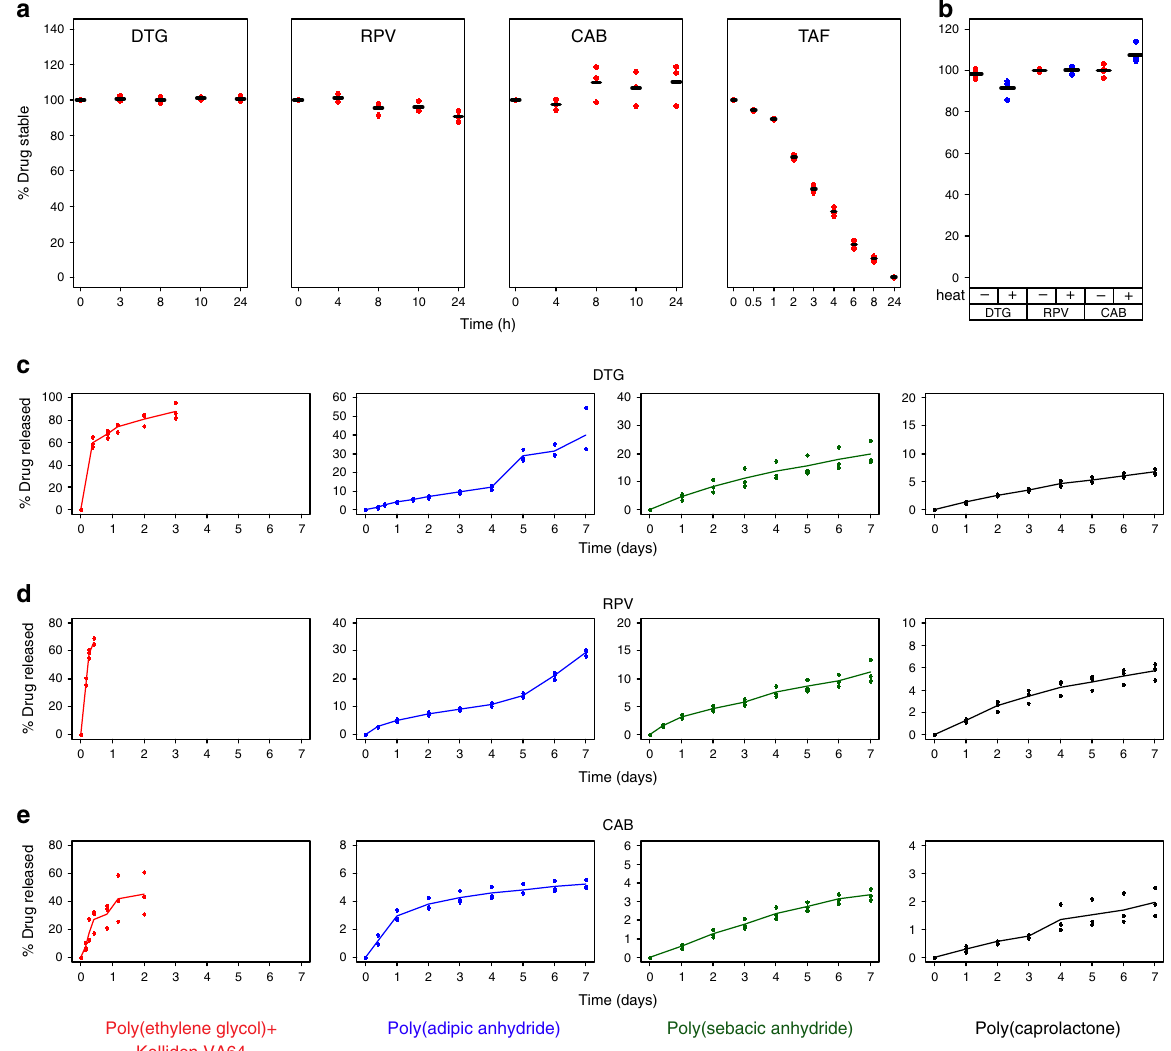
Fig. 3 Assessment of drug stability and release rates from different polymer matrices. a Different antiretroviral drugs were incubated in SGF for 24 h at 37 ° C. At various times, drug concentration in SGF was measured using HPLC. b Stability of various drugs upon incubation at 150 °C for 2 h was assessed using HPLC. Circles represent individual data points and horizontal lines indicate mean value. Release of DTG ( c ), RPV ( d ) and CAB ( e ) from various polymer matrices in SGF was measured using HPLC. Polymer matrices from left to right are: poly(ethylene glycol) + Kollidon VA64, poly(adipic anhydride), poly (sebacic anhydride) and poly(caprolactone). Circles are individual data points, and lines represent mean release pro fi